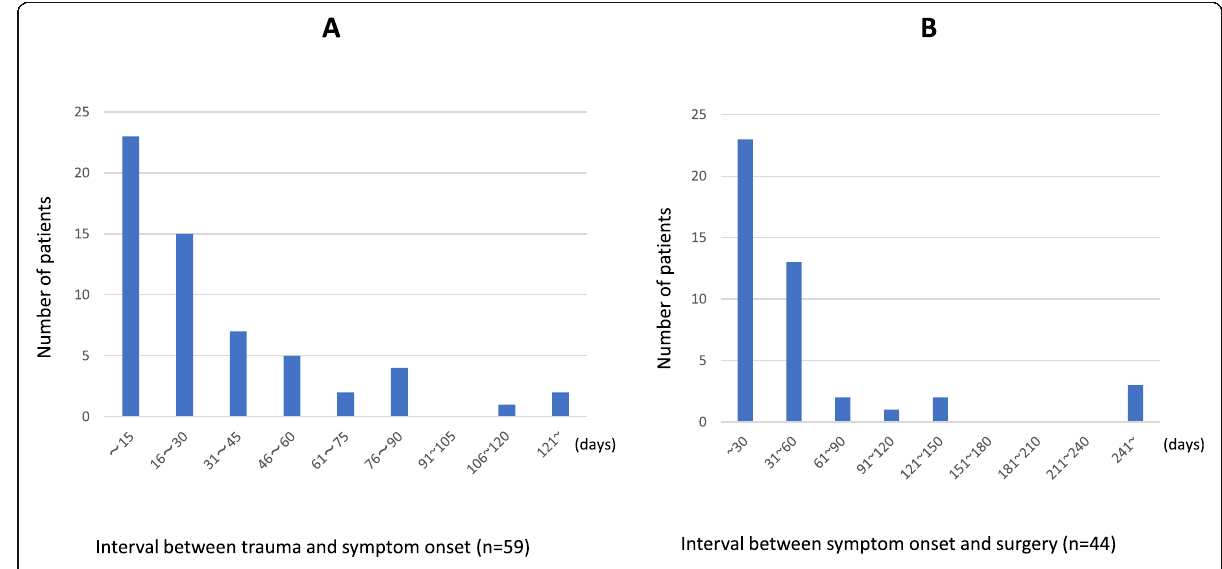
Fig. 7 a Interval between trauma and symptom onset. b Interval between symptom onset and